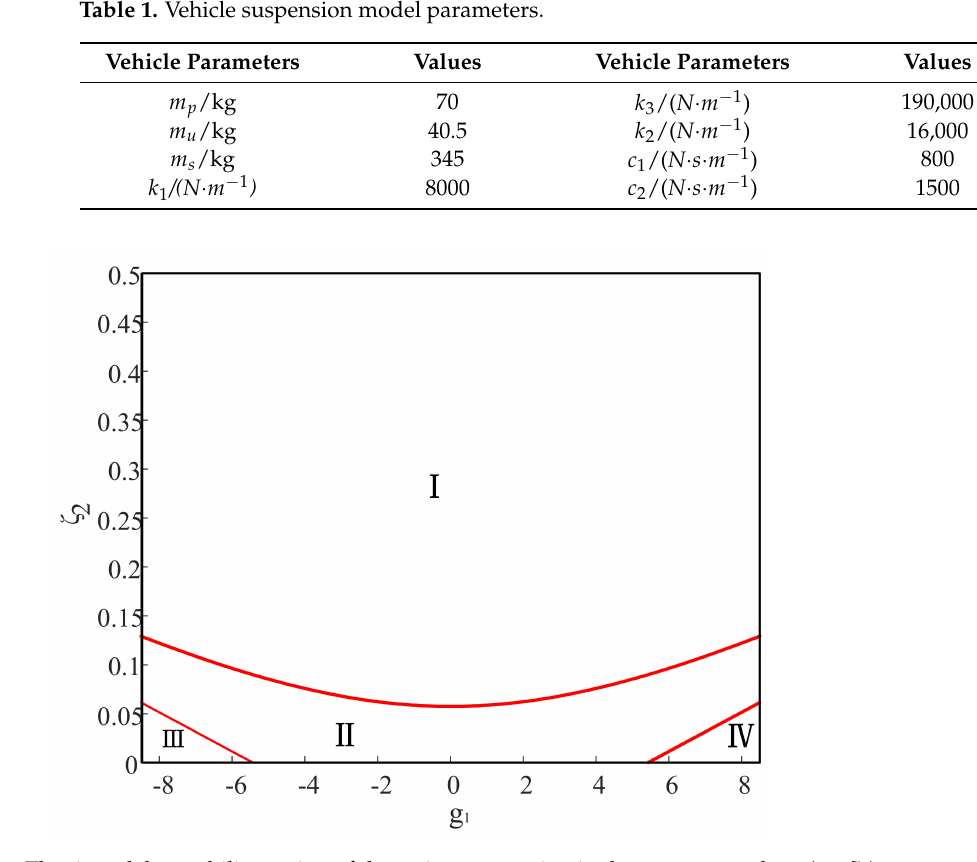
Figure 3. The time-delay stability region of the active suspension in the parameter plane ( g 1 , ζ 2 ). Table 2. The symbol sequence of the discriminant of active suspension and the number of real roots. Subarea